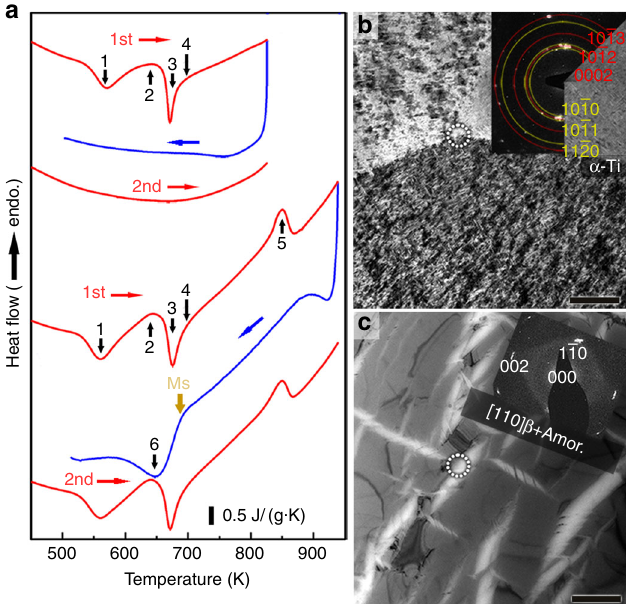
Fig. 4 Cyclic differential scanning calorimetry of a Ti 59.1 Zr 37 Cu 2.3 Fe 1.6 rod with a diameter of 8 mm and microstructures after different anneals. a When the as-cast alloy is heated to 823 K, four phase transformations proceed (1: β → β + ω , 2: ω → β , 3: β → α , 4: glass → α ). No transformations occur on cooling or immediate reheating. During heating the as-cast alloy to 943 K, the β -transus temperature (5: α → β ) is crossed. Subsequent cooling results in an exothermic event below 695 K. Since the same phase transformations take place on reheating like in the as-cast state, it reveals that this exothermic reaction (6) originates from partial amorphization of β - Ti ( β → β + amorphous). b The bright- fi eld TEM micrograph of the DSC sample annealed at 823 K and the SAED pattern from the marked region (inset) proves the presence of stable α -Ti. c After annealing at 943 K, the microstructure and the SAED pattern (inset) are identical to the as-cast state, which show β -Ti and the amorphous phase. Scale bars in b , c correspond to 1 μ